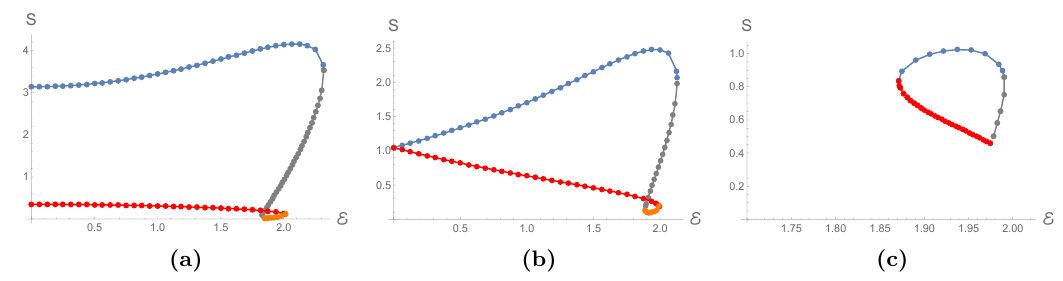
Figure 9. Black hole entropy as function of the electric (cid:12)eld for T = 1 =(cid:25) , T = 0 : 275665 and T = 0 : 24179 ( G N = 1). Plot (b) is for a temperature slightly above the minimal value allowed for AdS-Schwarzschild black holes, where the large and small black hole branches meet. Below this temperature neutral black holes only exist for a non-zero electric (cid:12)eld.